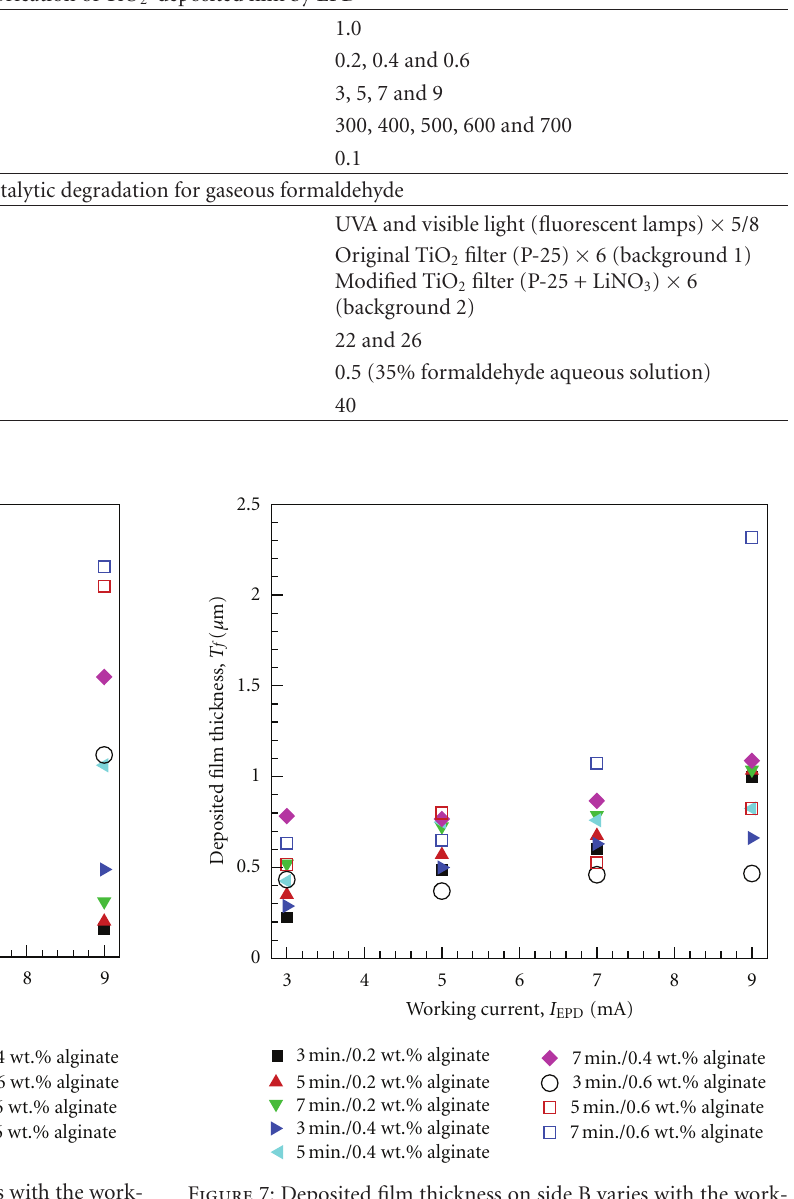
Figure 7: Deposited film thickness on side B varies with the work- ing currents dispersant for di ff erent concentration and